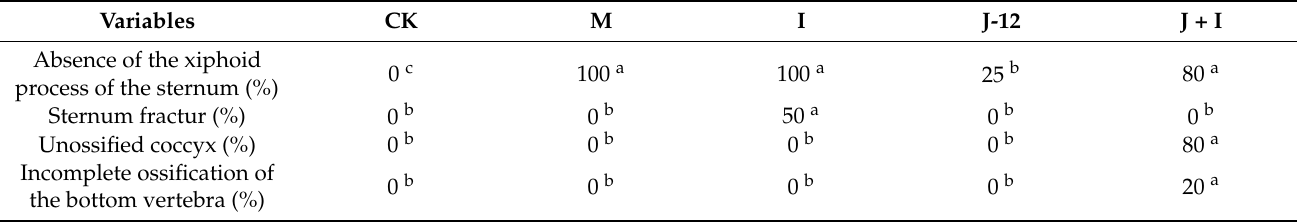
Table 3. Effect of J-12 on physiologic parameters of